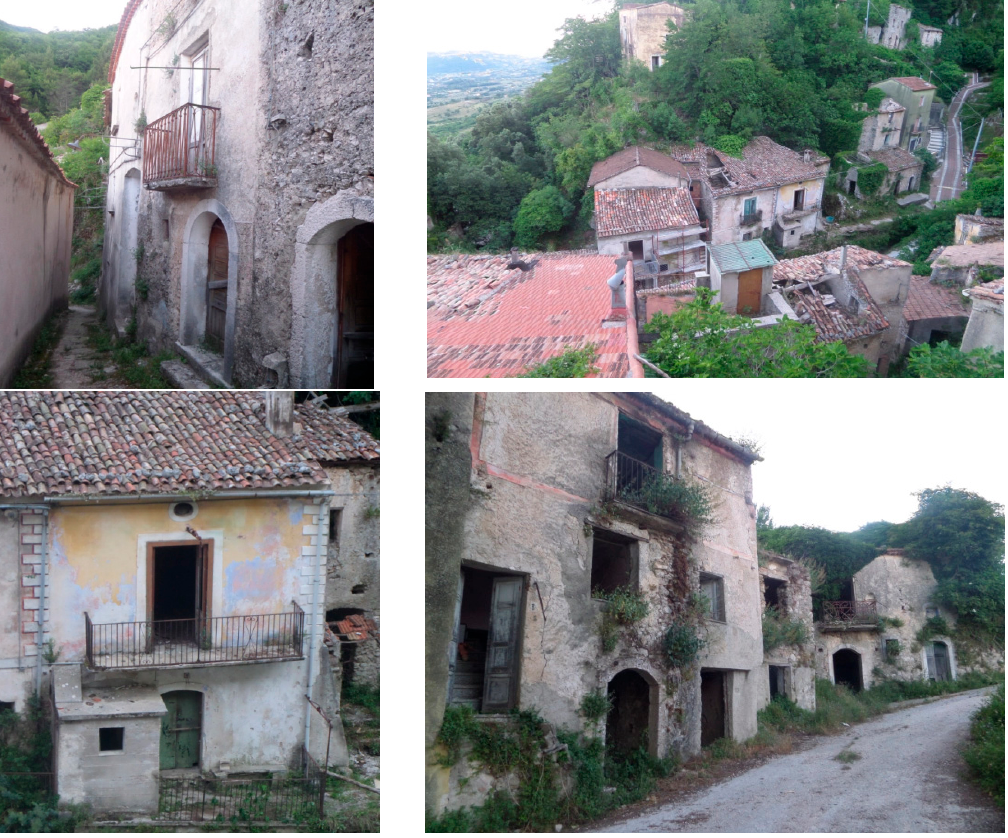
Figure 4. The street views of some building typologies inside the inspected historical centre of Senerchia.